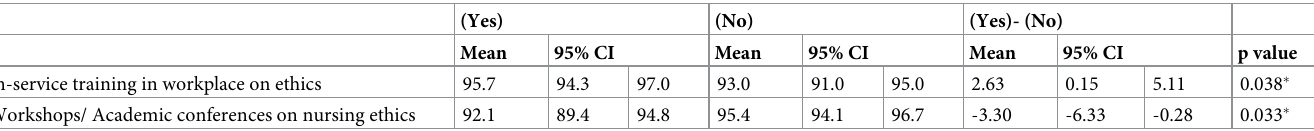
Table 5. Difference of multivariate-adjusted mean values of J-HECS26 (n =